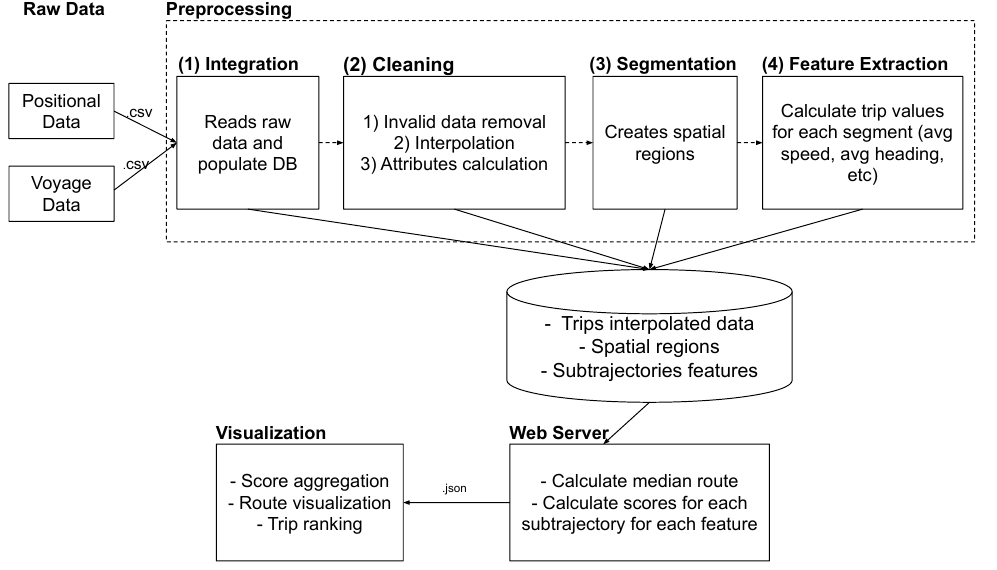
Figure 2. Overview of the framework of the Trip Outlier Scoring